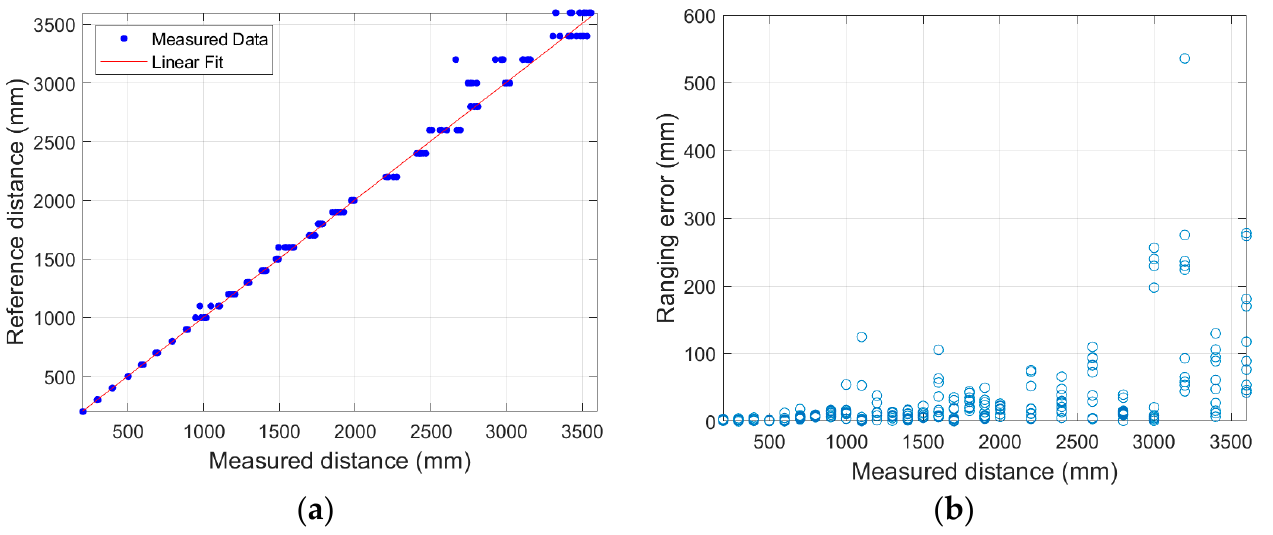
Figure 6. Distance measurements acquired through depth camera: ( a ) reference and measured distances with linear fit; and ( b ) ranging error caused by systematic bias.